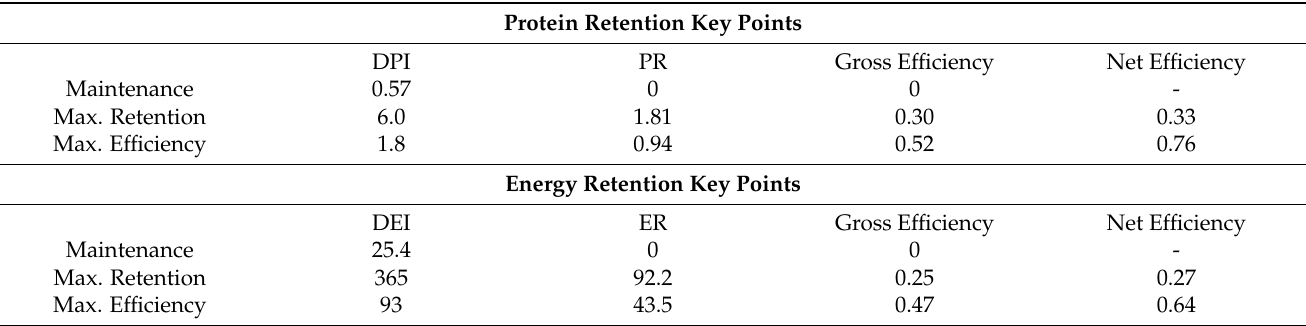
Table 4. Protein and energy retention key points.